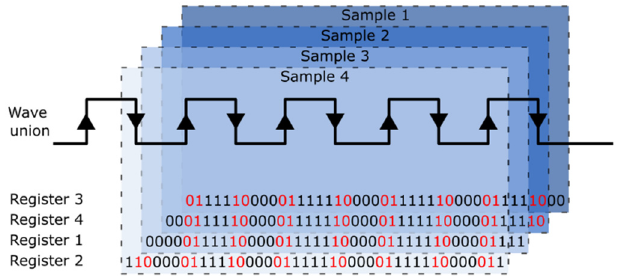
Figure 6. MSWU TDC operation principle. Register 1 (Sample 3) contains different number of transitions than other registers resulting in lower value of Σ R samp3 ( t ).